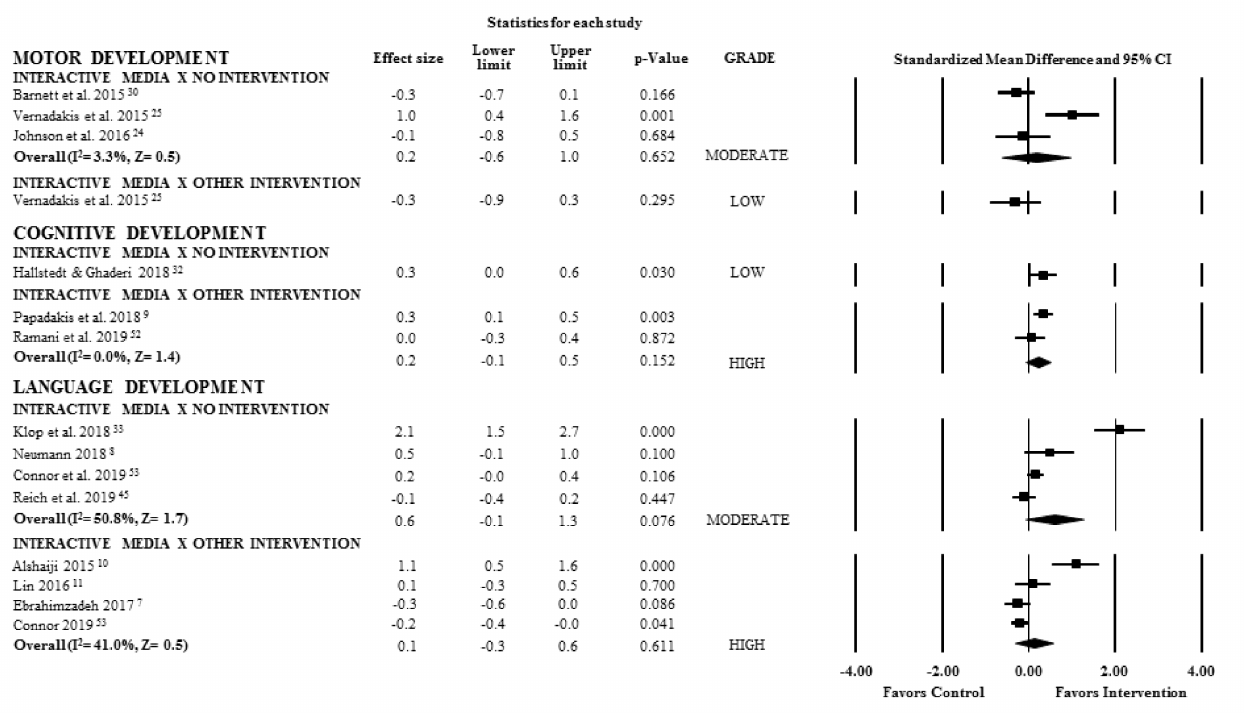
Figure 2 - Pooled results of interactive media compared with no intervention or other intervention on cognitive, language, and motor development at short-term follow-up in healthy children and adolescents. The right side favors intervention. Z, value Z; I2, statistic.